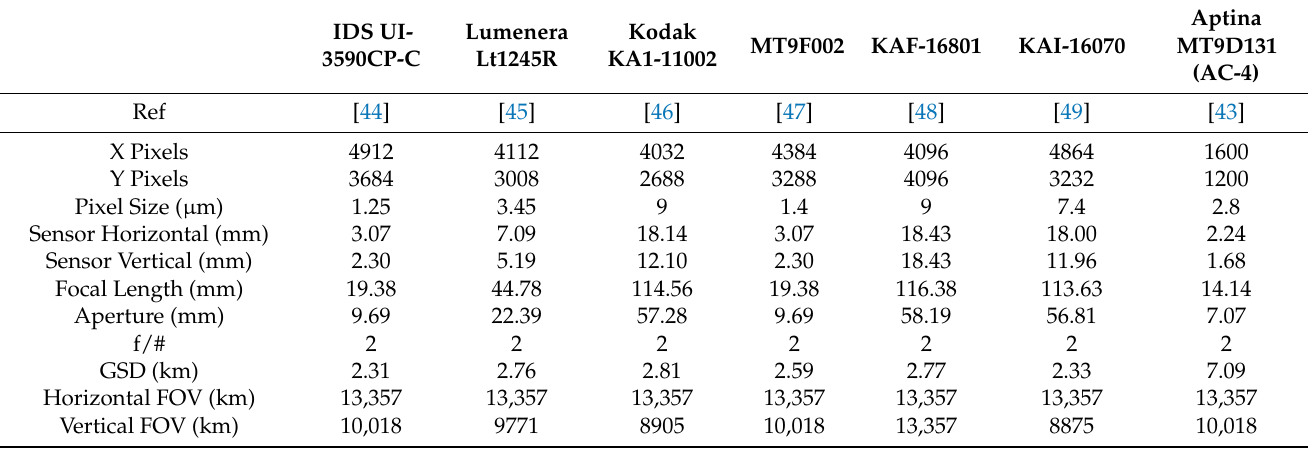
Table 3. Sensor specifications of 4K sensors and their calculated optics parameters for an 18 ◦ FOV in geostationary orbit. The AC-4 Megapixel sensor (Aptina MT9D131 [26]) is also included for comparison.